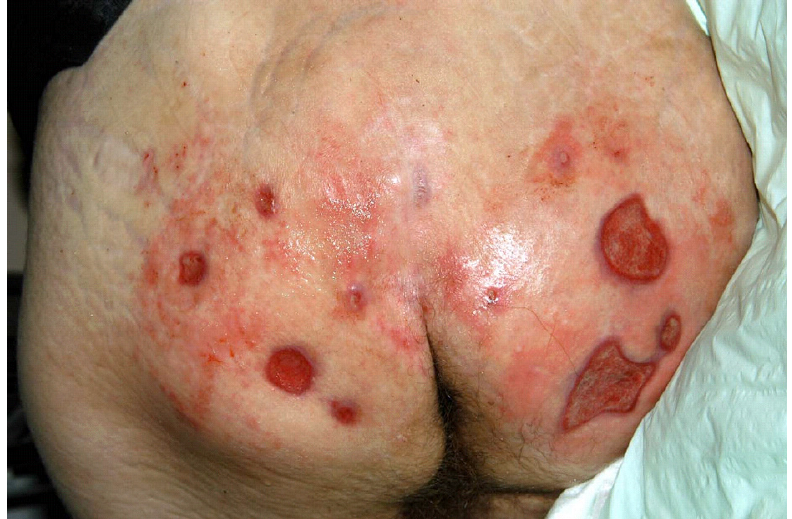
Fig. 3 Gluteal ulcerations of our patient before anti TNF alpha therapy (picture per- formed in July 2002).